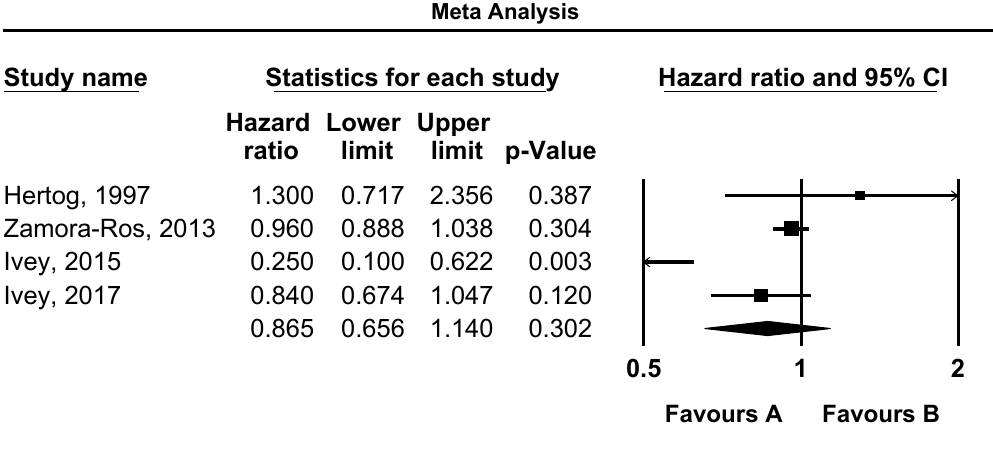
Figure 4. Forest plot of flavonoid intake and risk of cancer mortality.